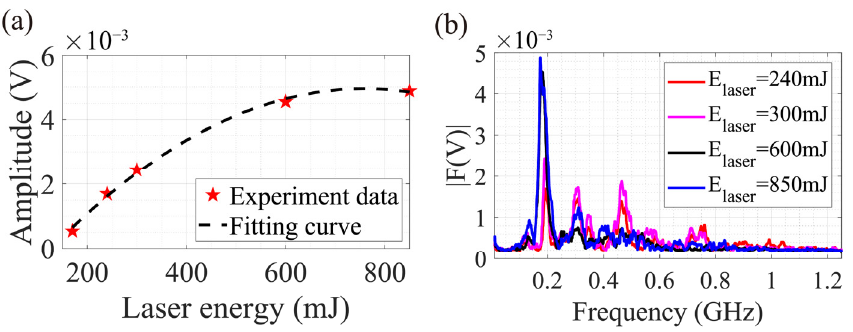
Figure 6. ( a ) The amplitude of EMPs as a function of laser energy. ( b ) Comparison of EMP spectra for four laser energies. The corresponding parameters are: t = 30 fs, d = 40 cm, θ = 0°, and different values of E are 240, 300, 600, 850 mJ.